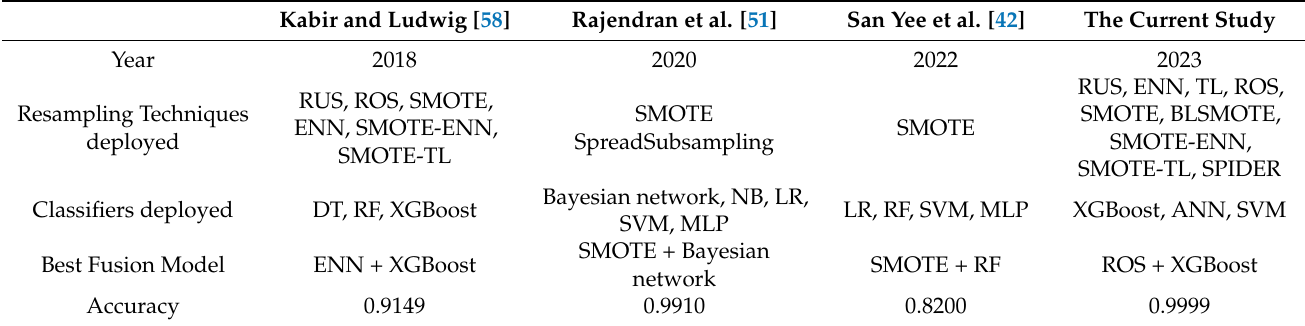
Table 15. Comparative analysis of the current and previous studies on the BCSC